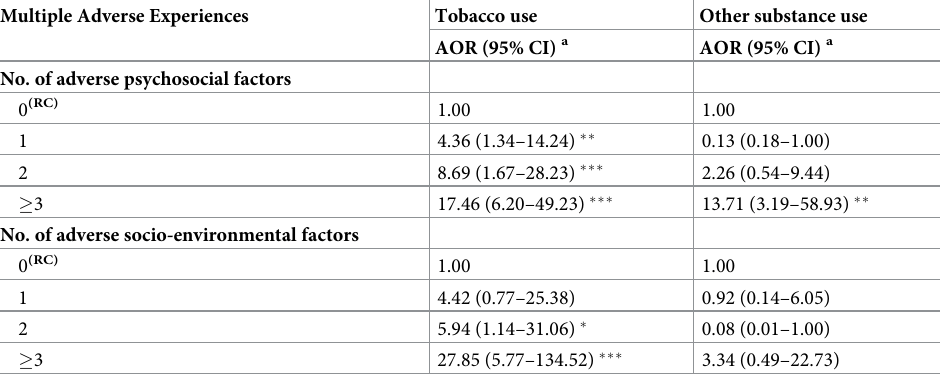
Table 4. Association between multiple adverse experiences and adolescents’ tobacco and other substance use in Bangladesh, 2014. Multiple Adverse Experiences Tobacco use Other substance use AOR (95% CI)